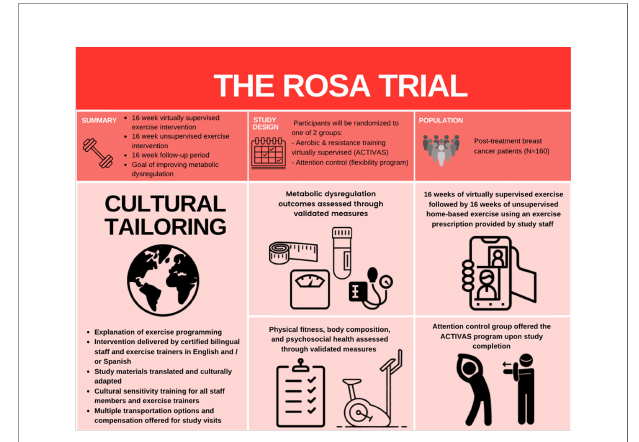
FIGURE 1 | Conceptual Framework of the ROSA